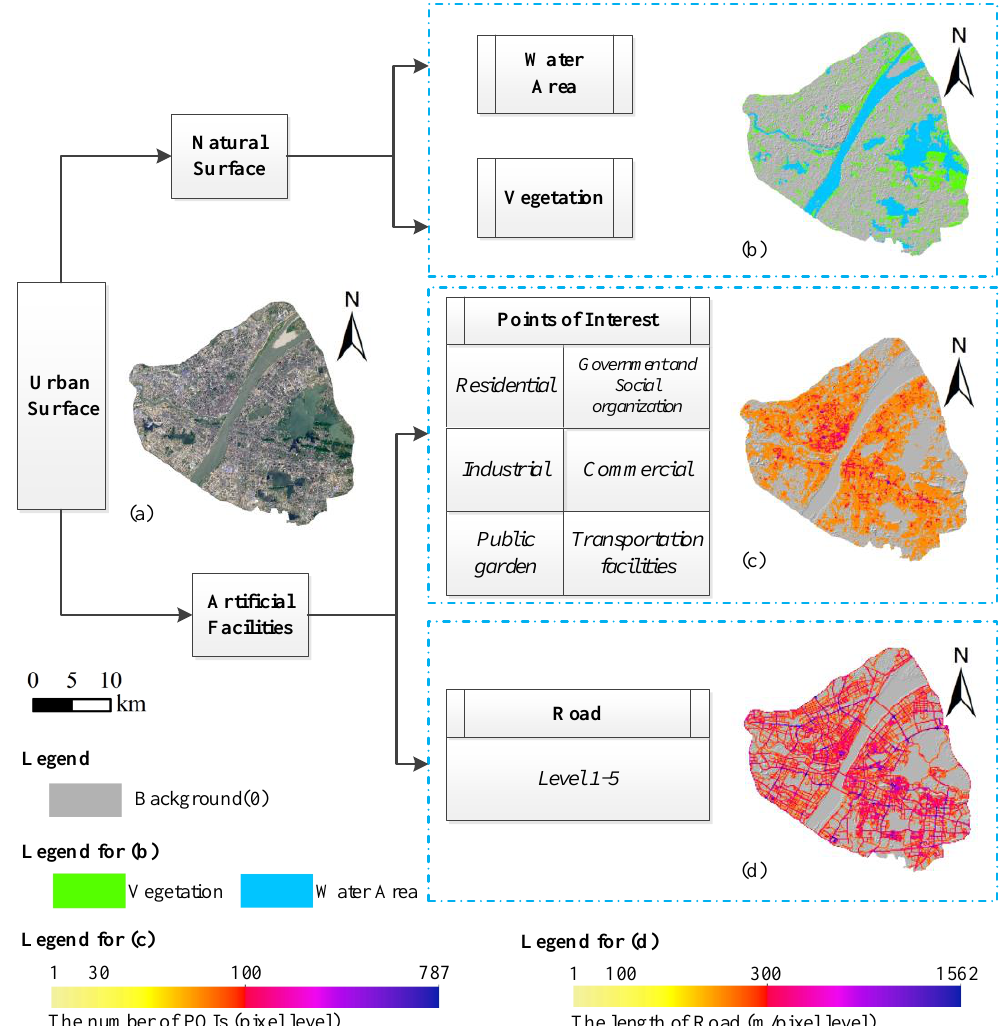
Figure 2. Spatial distribution of independent variables: ( a ) Landsat 8 image; ( b ) natural surface spatial distribution map: include water area and vegetation; ( c ) POI density map: composed with all types of POIs; ( d ) road density map: composed with all levels of roads.